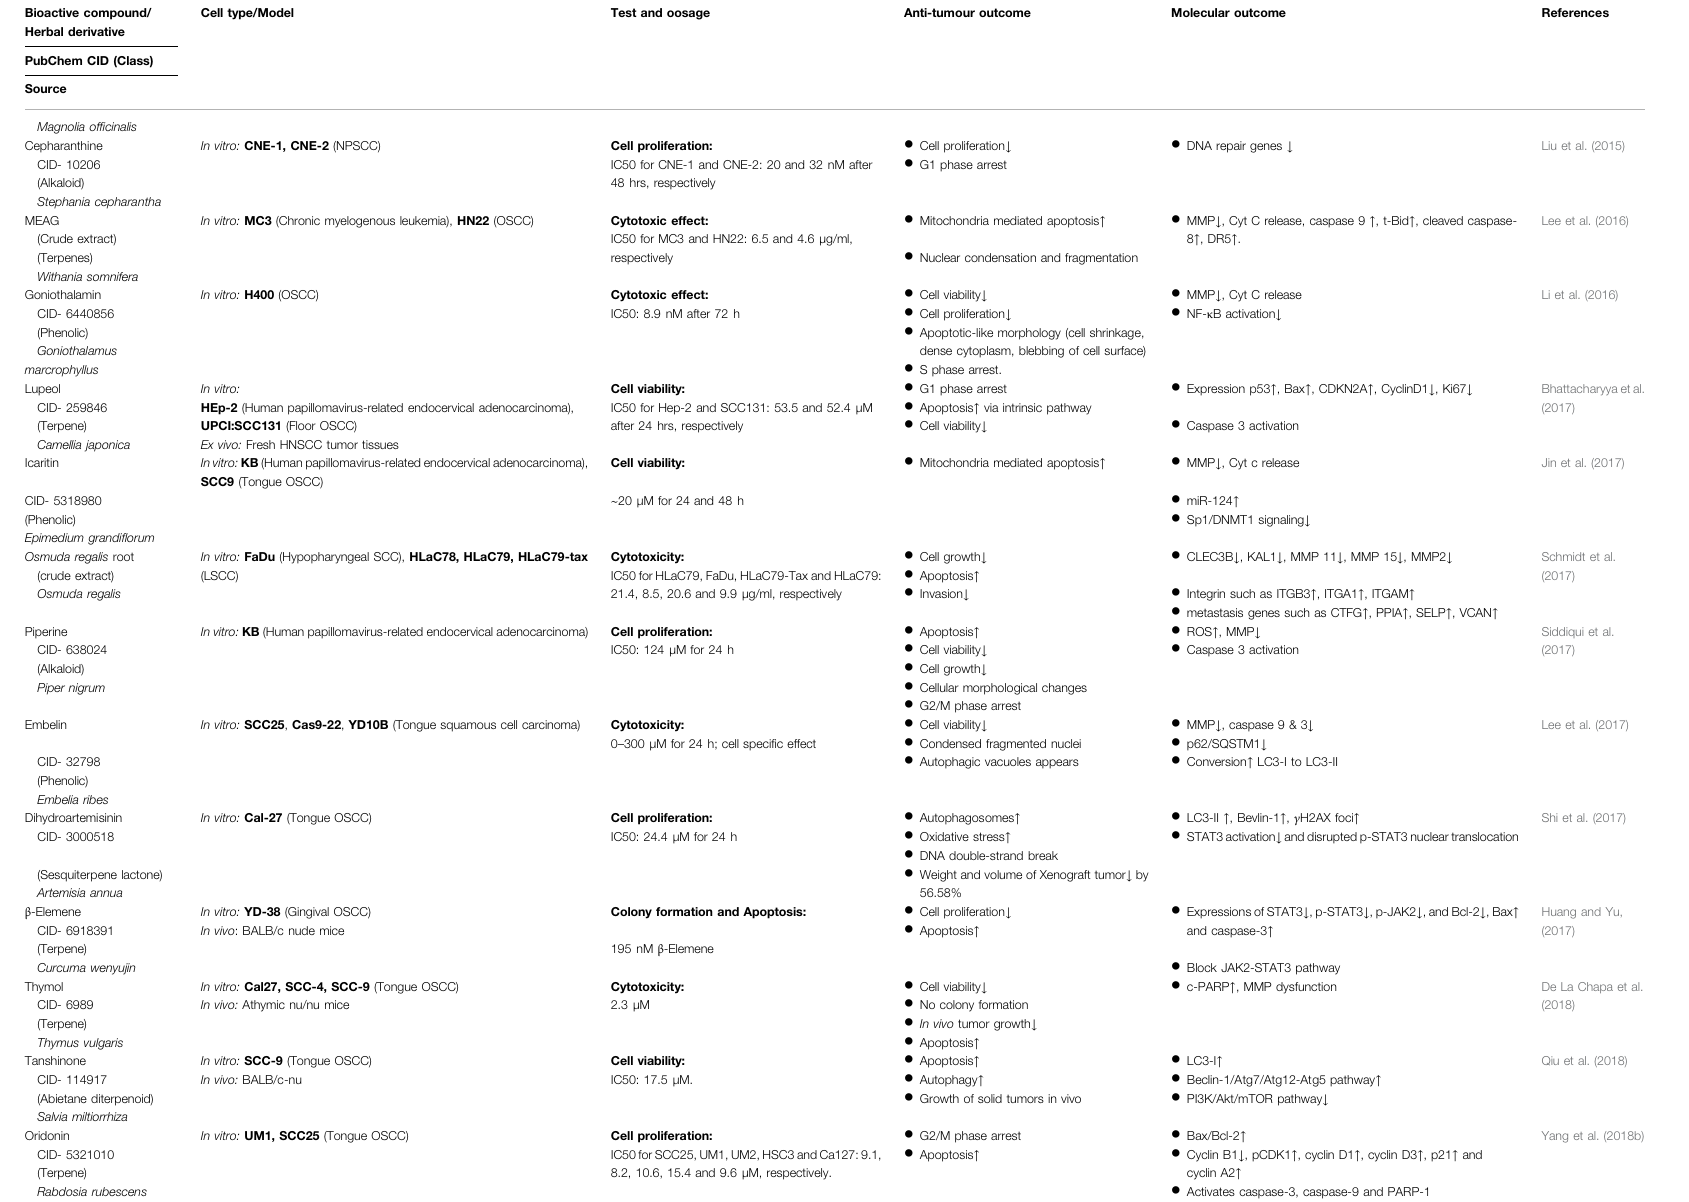
TABLE 4 | ( Continued ) Preclinical studies showing therapeutic phytochemicals/herbal derivatives against tobacco/alcohol-associated